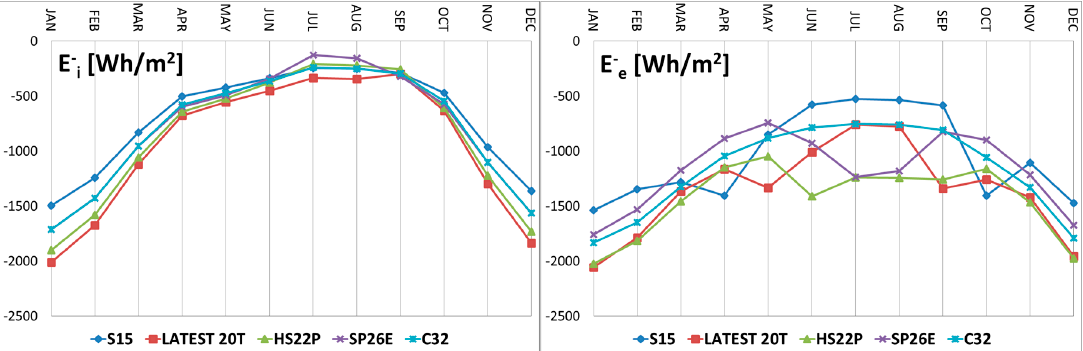
Figure 4. Monthly average daily total E T , latent E L and sensible E S energy stored in the